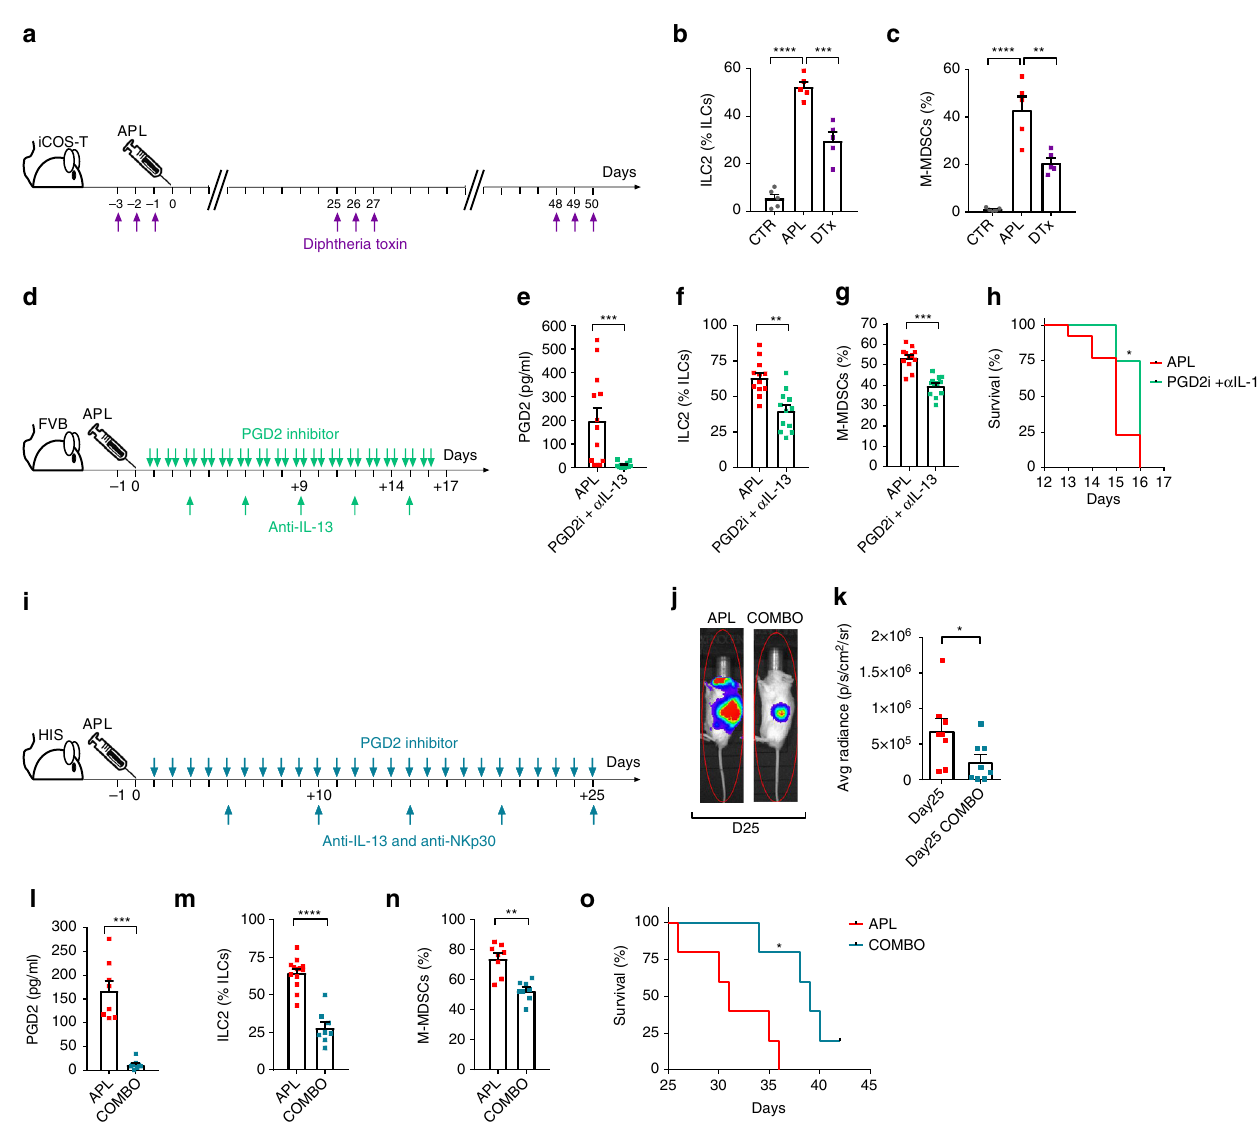
Fig. 5 Therapeutic interference of the PGD2-ILC2-IL-13-M-MDSC immunosuppressive axis. a Schematic representation of DTx treatment schedule in iCOS-T mice upon injection of APL splenocytes (one independent experiment). b Quanti fi cation of ILC2 and c M-MDSCs frequencies in control mice (CTRL), APL mice (APL) and iCOS-T APL mice (DTx) ( n = 5). d Schematic representation of the schedule of PGD2 inhibitor (TM30089) and anti-IL-13 neutralizing antibody treatment in FVB/NJ mice injected with APL blasts (two independent experiments). e Comparison of serum concentrations of PGD2 (APL n = 13, PGD2i + α IL-13 n = 12), f ILC2 frequencies (APL n = 12, PGD2i + α IL-13 n = 12), g M-MDSC frequencies (APL n = 12, PGD2i + a IL-13 n = 12). h Survival curves of untreated (APL) and PGD2i + α IL-13-treated FVB/NJ mice injected with APL blasts (APL n = 12, PGD2i + α IL-13 n = 12). i Schematic representation of the schedule of PGD2 inhibitor (TM30089), anti-NKp30 blocking antibody and anti-IL-13 neutralizing antibody treatment in HIS mice injected with APL blasts (one experiment). j Representative examples and k cumulative data of luminescence measurement in untreated APL HIS mice (APL) and mice treated with PGD2 inhibitor (TM30089), anti-NKp30 blocking antibody and anti-IL-13 neutralizing antibody (COMBO) for quanti fi cation of leukaemic engraftment ( n = 8). l Quanti fi cation of PGD2 concentrations ( n = 8), m ILC2 frequencies (APL n = 13, COMBO n = 8) and n M-MDSCs frequencies in untreated APL HIS mice (APL) and mice treated with PGD2 inhibitor (TM30089), anti-NKp30 blocking antibody and anti-IL-13 neutralizing antibody (COMBO) ( n = 8). o Survival curves of untreated APL HIS mice and APL HIS mice treated with PGD2 inhibitor (TM30089), anti-NKp30 blocking antibody and anti-IL-13 neutralizing antibody (COMBO; n = 5). Error bar s are s.e.m. Statistical analysis was performed using Kruskal-Wallis test ( b , c ), Mann-Whitney test ( e – g , k , l – n ) and Log-rank test (Mantel-Cox) ( h , o